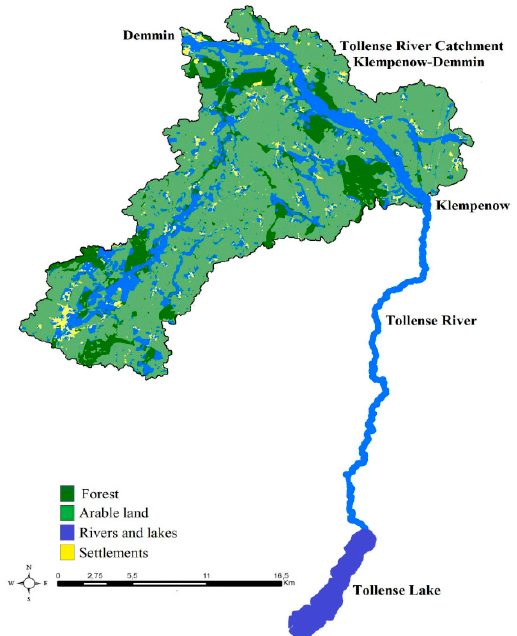
Figure 2. Tollense River originating from Tollense lake in Neubrandenburg towards its downstream end in Demmin, and land use in Tollese river catchment from Klempenow to Demmin. © Rivers lakes and land use data was provided by “State office for the Environment, Nature Conservation and Geology Mecklenburg-Vorpommern” (LUNG-MV) [40].